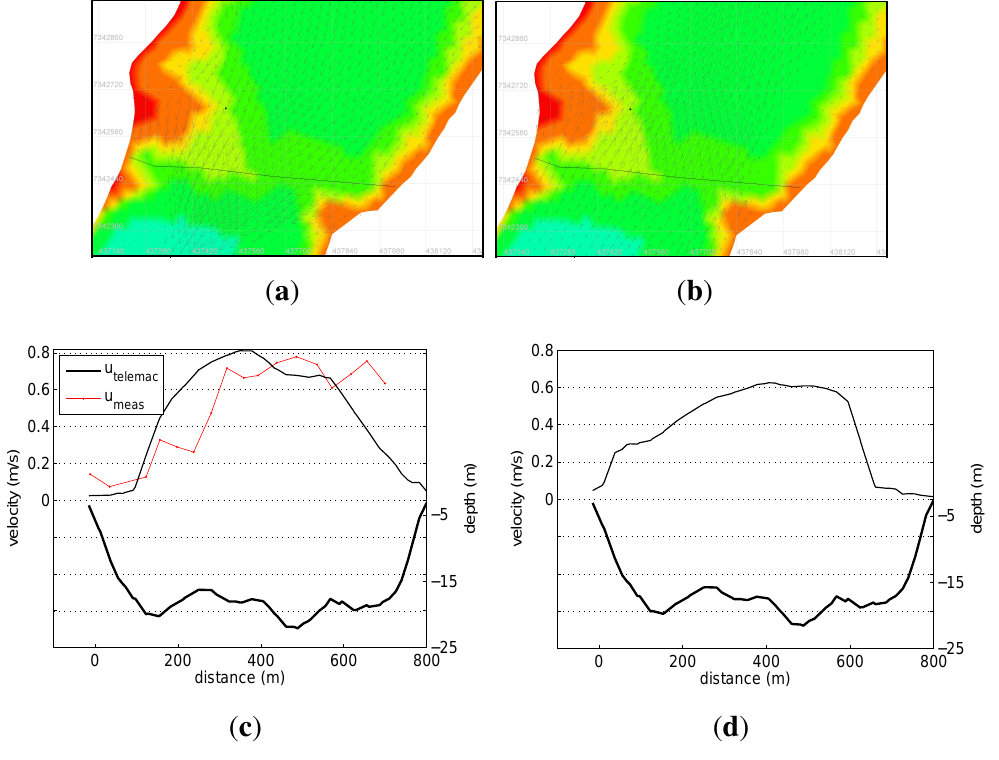
Figure 10. Velocity field in the sound Skarpsundet modelled with TELEMAC. The tidal range was at the time of the simulation 200 cm (left) and 190 cm (right). Velocity in ( a ) incoming tide; and ( b ) outgoing tide is marked with arrows, and the colours represent the bathymetry. The ADCP measurements are marked out where the dot represents the long-time measurement and the line the cross-sectional measurement; ( c ) Incoming tide profile; and ( d ) outgoing tide profile show velocity extracted at the same location as the cross-sectional measurement (thin lines) and depth (thick lines). The cross-sectional measurement is plotted in ( c ) for a